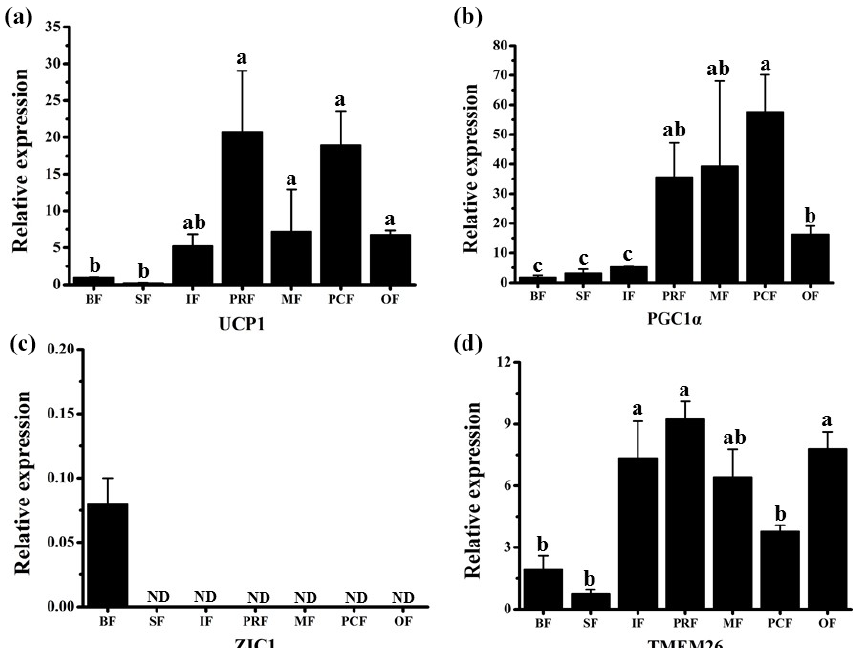
Figure 3. Expression profile of adipocyte markers in adipose tissue depots of fattened buffalo. The relative mRNA expression levels of four adipocyte markers, UCP1 (a) , PGC1 α (b) , ZIC1 (c) , and TMEM26 (d) , analyzed by RT-qPCR. Expression levels were normalized to β -actin. Data are shown as the mean ± SEM ( n = 6). Different lowercase letters (a–c) indicate significant difference ( p < 0 . 05) between depots. ND, not